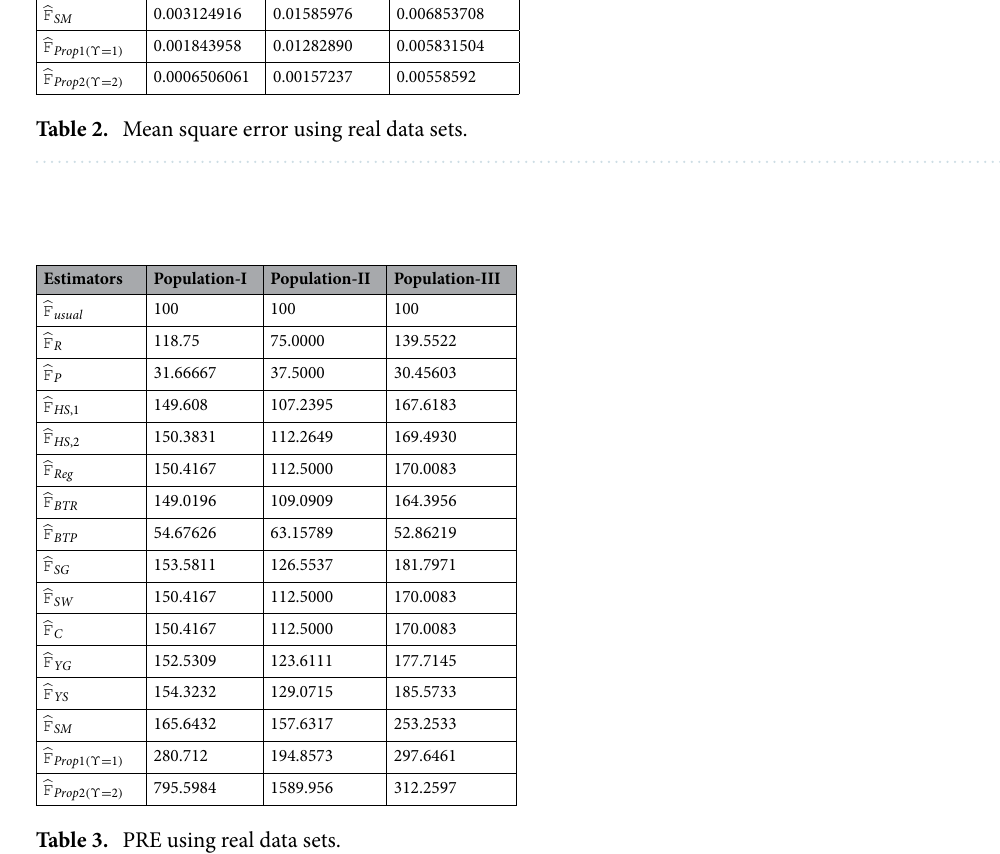
Table 3. PRE using real data